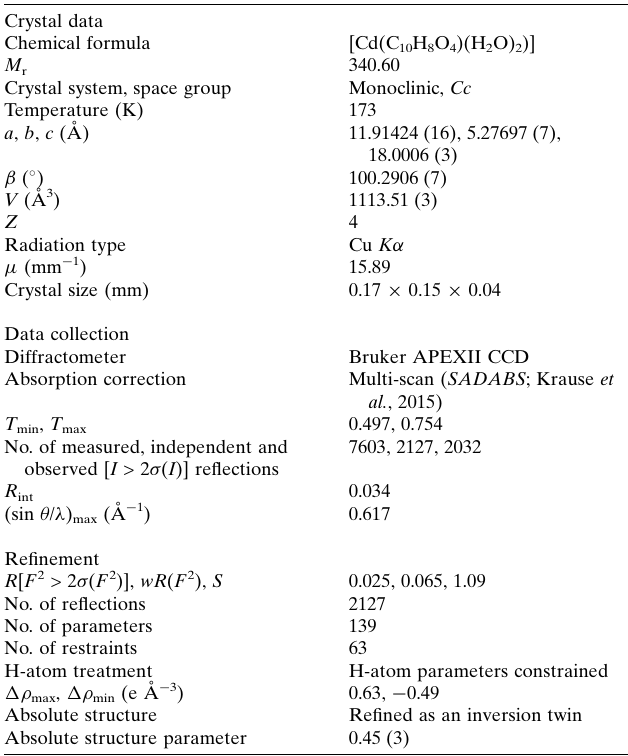
Table 2 Experimental details.